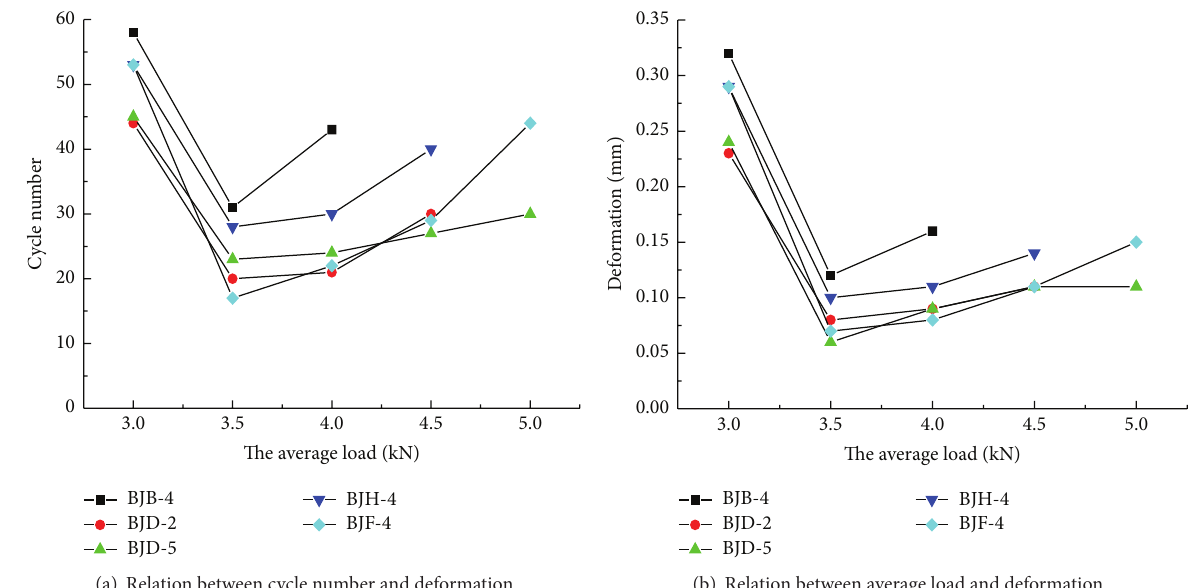
Figure 8: Deformation law along with the average load.